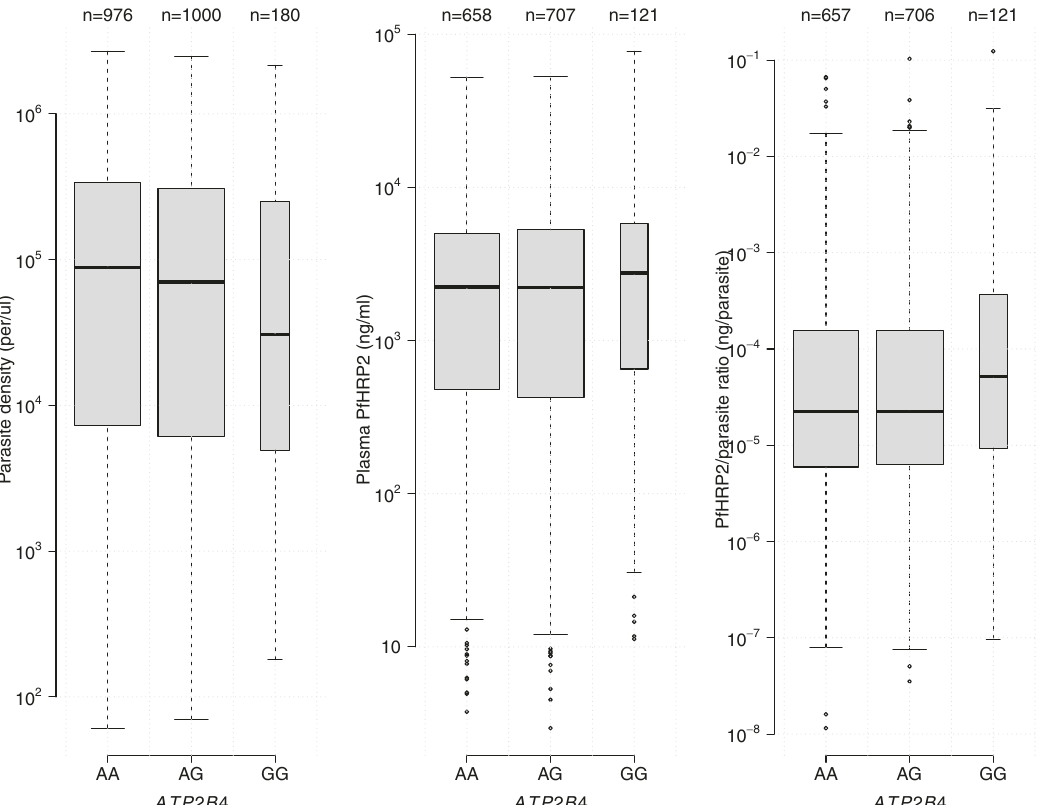
Fig. 3 Distributions of plasma Pf HRP2, parasite density, and Pf HRP2/parasite ratio across the ATP2B4 genotypes (rs1541255). Boxplots (center: median; bounds of box: interquartile range; whiskers: 1.5 standard deviations; points: outliers) are based on the observed data; the width of each boxplot is proportional to the square root of the number of data points.